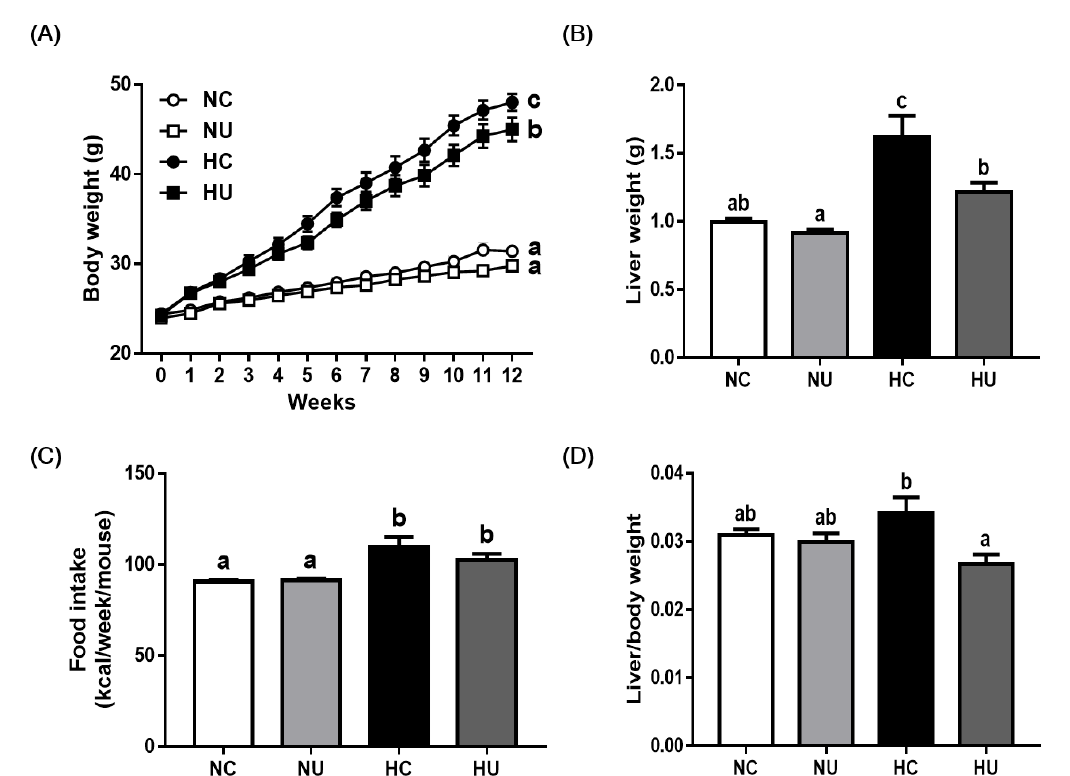
Figure 1. Effects of Bacteroides uniformis CBA7346 treatment on body and liver weight in mice with high-fat diet-induced non-alcoholic fatty liver disease. ( A ) Body weight changes during 12 weeks; ( B ) liver tissue weight (g); ( C ) food intake during the 12 weeks of feeding; ( D ) ratio of liver weight to body weight. NC, control group on normal diet; NU, group on normal diet receiving 1 × 10 6 CFU B. uniformis CBA7346 thrice a week; HC, control group on high-fat diet; HU, group on high-fat diet receiving 1 × 10 6 CFU B. uniformis CBA7346 thrice a week. Data are presented as mean ± SEM ( n = 9). Means with different letters (a–c) indicate significant difference ( p < 0.05) among groups at 12 weeks. Groups were compared using Duncan’s multiple range tests.